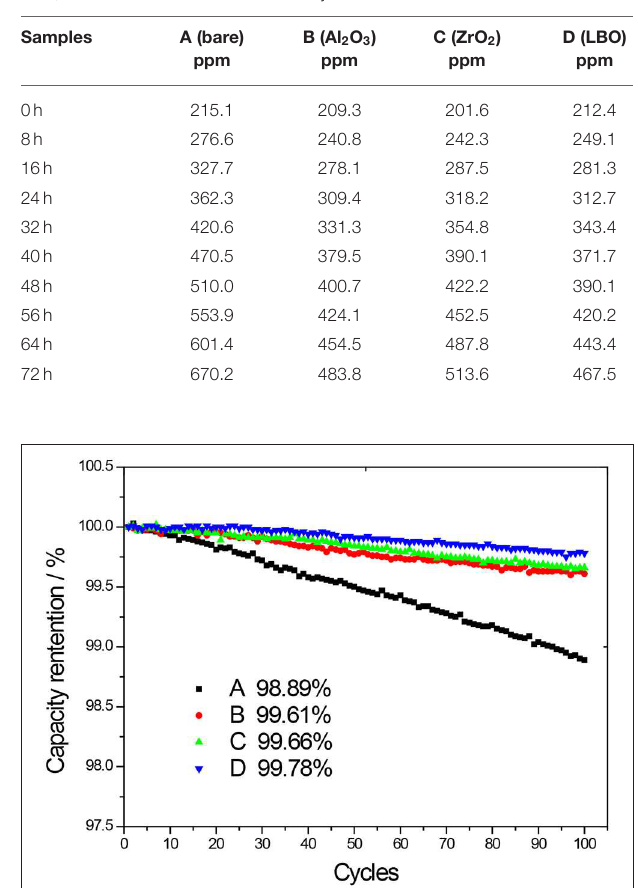
FIGURE 8 | Capacity retention as a function of cycle number of the LIBs composed of NCM811 and NCM811 coated by different